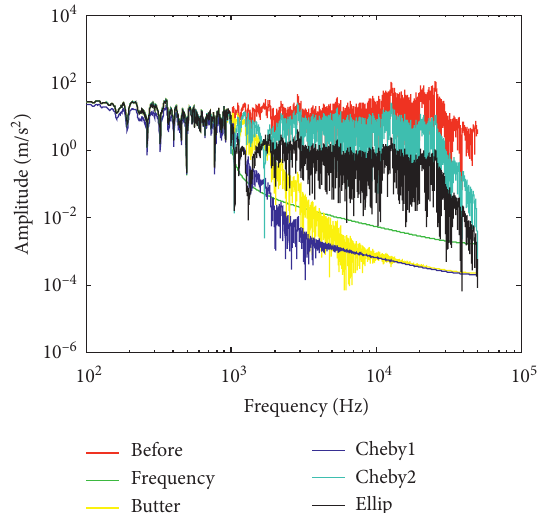
Figure 6: Frequency spectrum of signals filtered by different